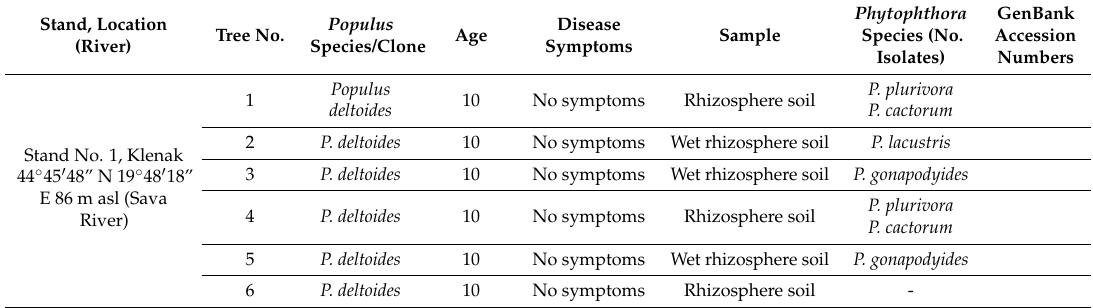
Table 1. Isolation of Phytophthora species from rhizosphere soil samples in poplar plantations in Serbia. Populus Stand, Location Disease Tree No. Age (River) Species/Clone Symptoms